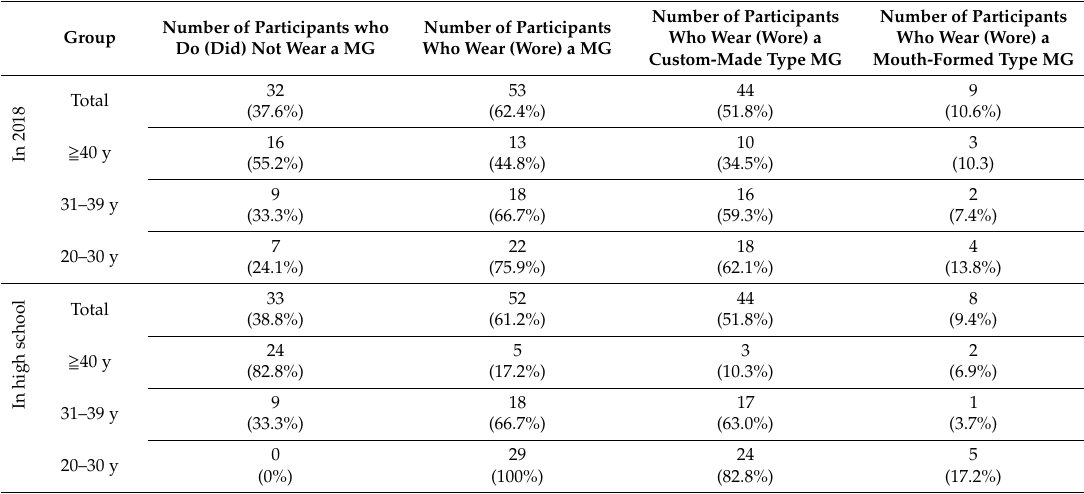
Table 3. MG wearing rates of study participants.